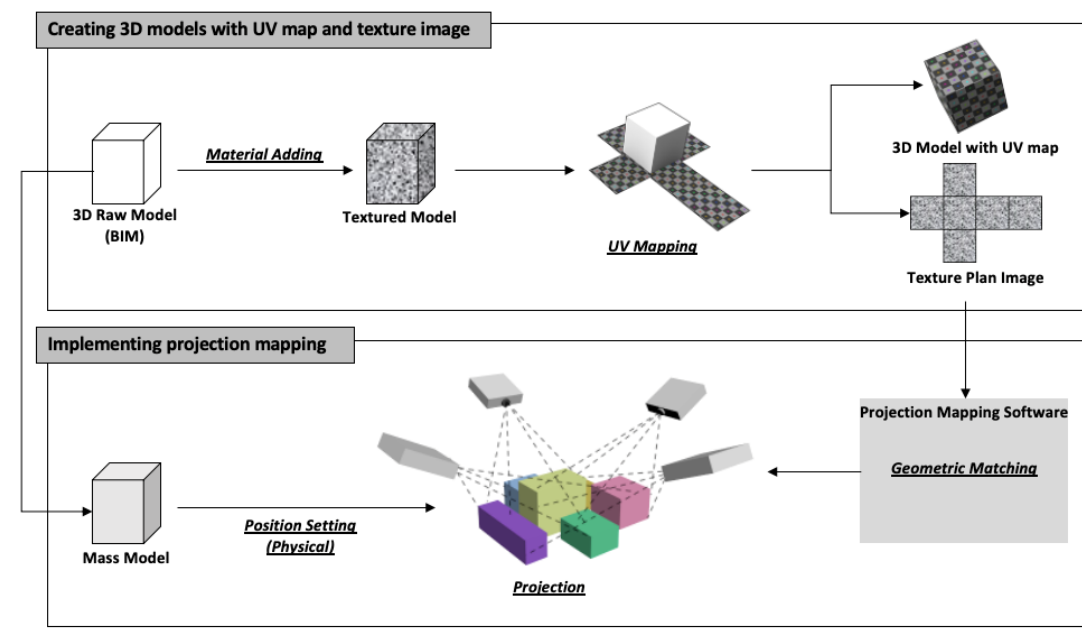
Figure 2. BIM-based SAR Implementation Framework for Building Design Prototyping.